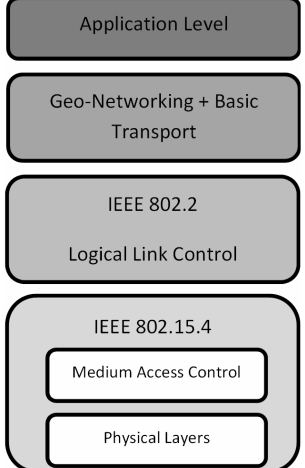
Figure 1. Modification of the ISO model stack for